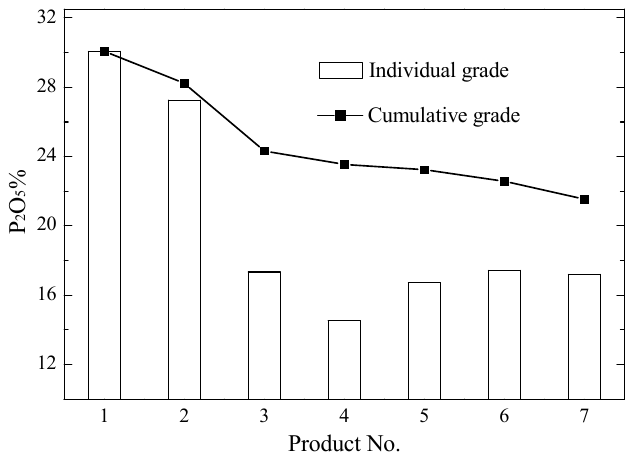
Figure 8. P 2 O 5 cumulative grade curve.